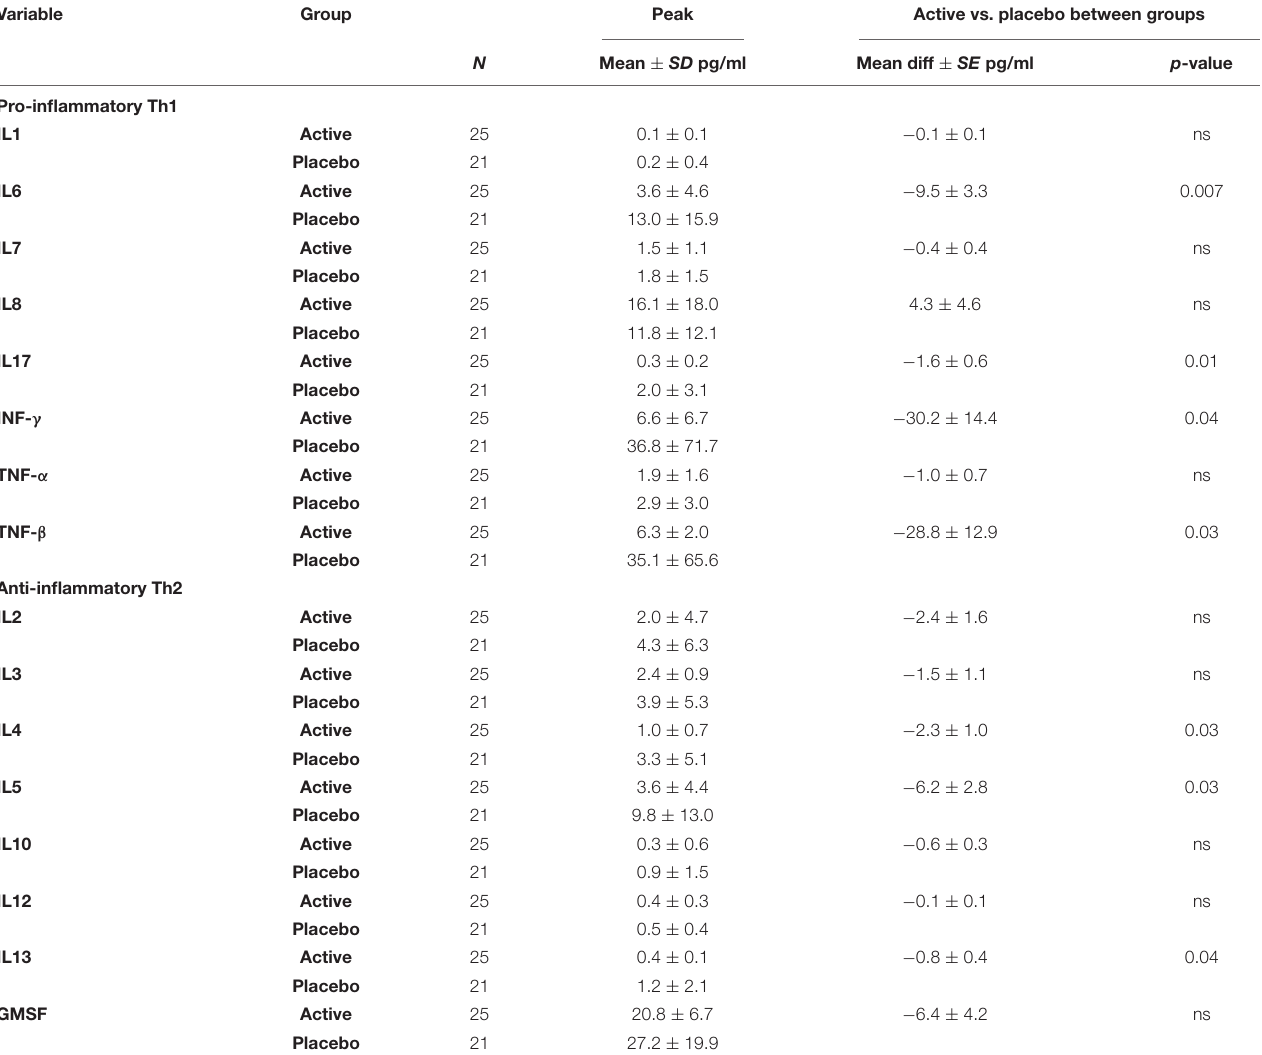
TABLE 6 | Cytokines ( N = 46).